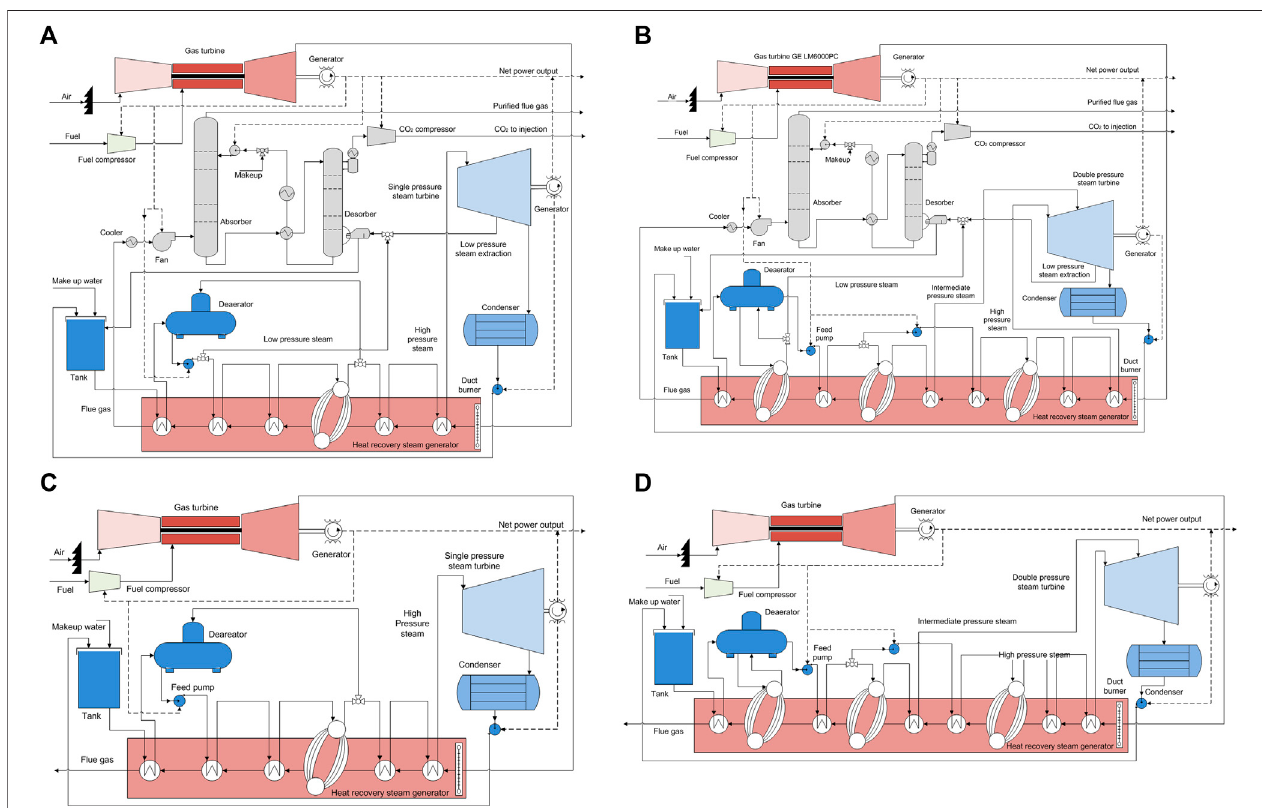
FIGURE3| StructureandnumberofMPUsconsideredforeachpowerhubscenario: (A) withCCSunitandsinglepressuresteaminjectiontosteamturbine( N 1 +1); (B) with CCS unit and double pressure steam injection to steam turbine ( N 2 +1); (C) without CCS unit and single pressure steam injection to steam turbine ( N 3 +1); (D) without CCS unit and double pressure steam injection to steam turbine ( N 4 +1)